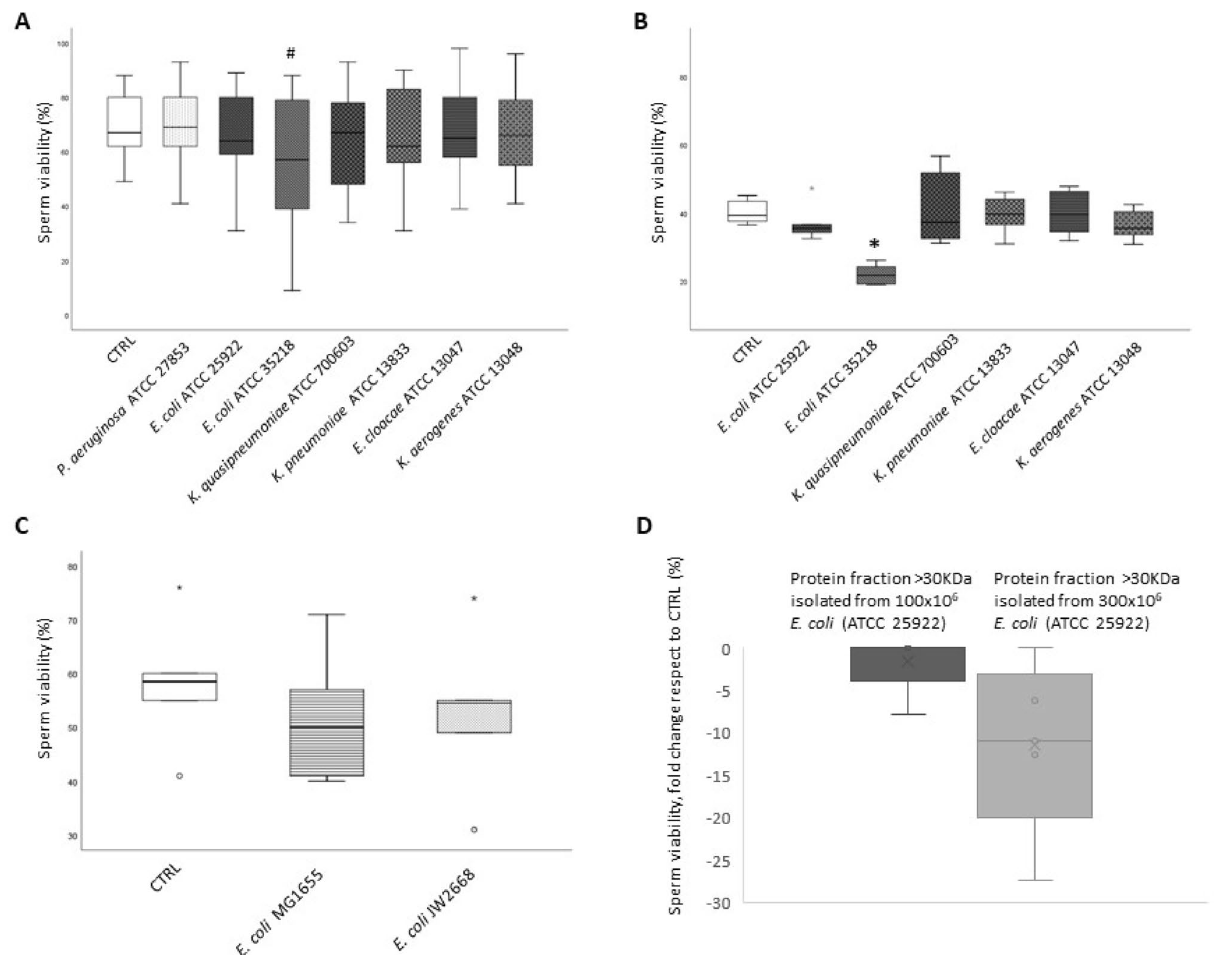
Figure 4. Box-plots representing the effect of 3 h in vitro incubation (37 °C, 5%CO 2 ) of whole semen samples with various bacterial strains ( P. aeruginosa ATCC 27853 , E. coli ATCC 25922 , E. coli ATCC 35218 , K. quasipneumoniae ATCC 700603 , K. pneumoniae ATCC 13883 , E. cloacae ATCC 13047 and K. aerogenes ATCC 13048) on sperm viability determined by eosin staining (n = 16, panels A and C ) and by the LIVE/ DEAD™ Fixable Green Dead Cell Stain (n = 6, panel B ). In panel C , box-plots representing the effect of 3 h in vitro incubation (37 °C, 5%CO 2 ) of whole semen samples (n = 6) with E. coli MG1655 (wild-type strain) and E. coli JW2668 (knockout for SIF) on sperm viability. In panel D , box plots representing sperm viability fold change respect to CTRL of 5 subjects after incubation with supernatants of E. coli ATCC 25922 obtained from a different number of cultured bacteria (100 and 300 × 10 6 ), after isolating protein fractions ≥ 30 KDa. Wilcoxon test, *p < 0.05; #p < 0.01 versus